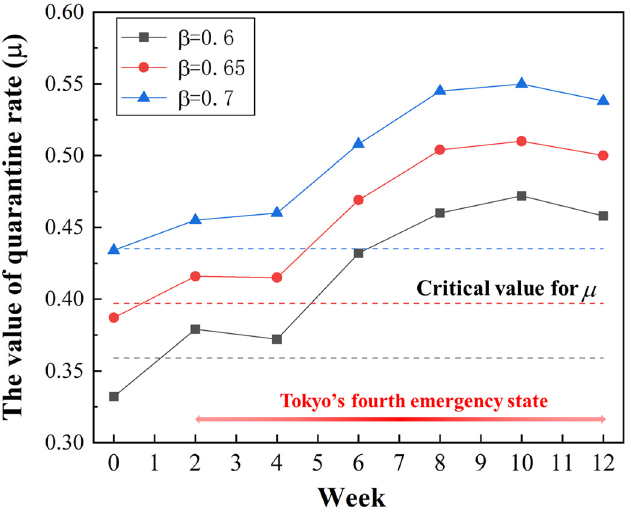
Figure 8. Appropriate quarantine rates per week under different transmission rates.